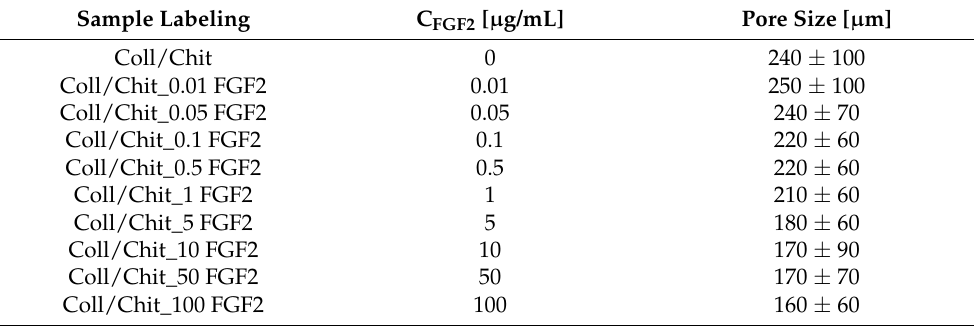
Table 1. Sample labeling, the used FGF2 concentration and pore size of prepared scaffolds. Sample